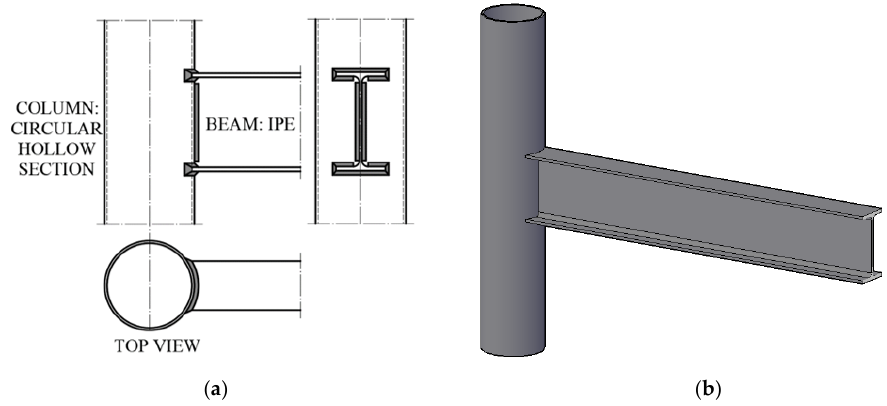
Figure 1. Analysed connection: plan-views ( a ) and 3D view ( b ).